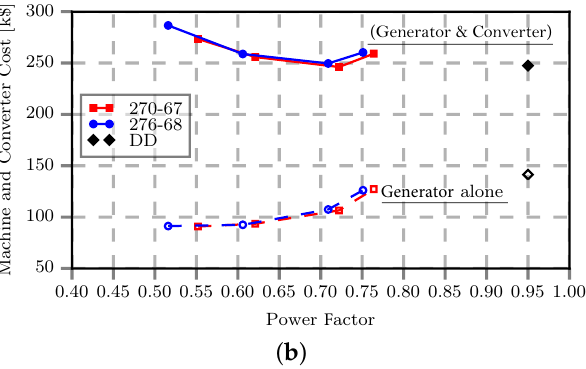
Figure 16. Comparison of 3MW PMVMs and system costs: ( a ) Type-A PMVM ( b ) Type-B PMVM. Note that the solid markers represent the system (generator and converter) costs while the cor- responding hollow markers show the generator cost (©[2020] IEEE. Reprinted, with permission from [20]). Table 6. Mass and cost comparisons of different 3 MW PMSM [32,35] and